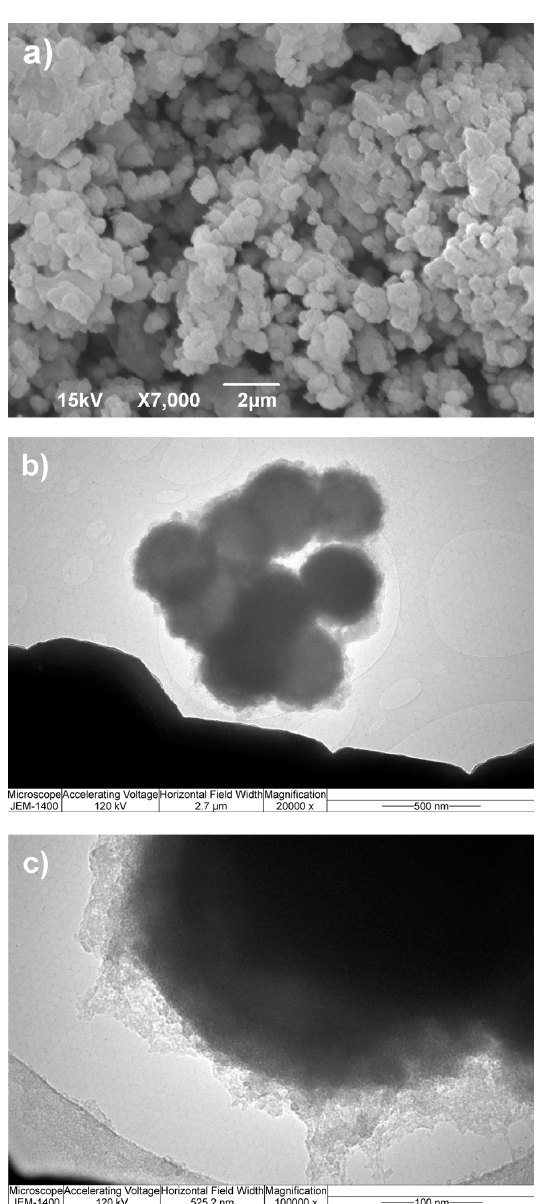
Figure 12. SEM (a) and TEM (b, c) micrographs of silica core/ four-layered ferrite/silica shell (sample